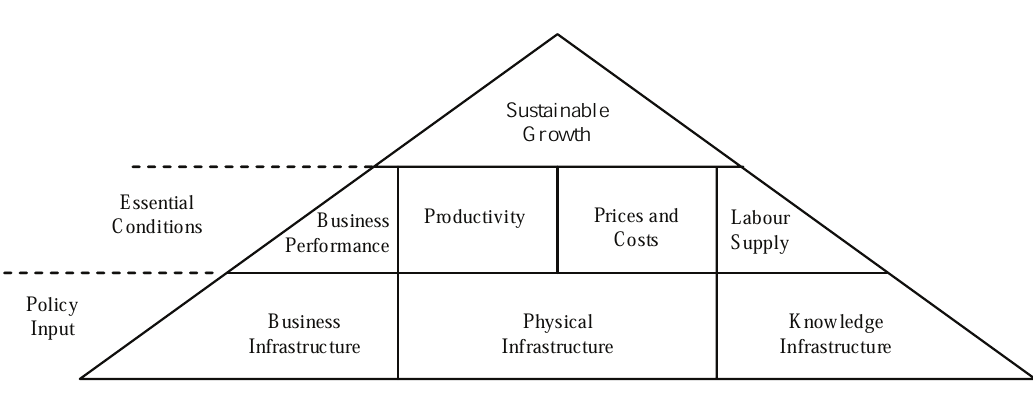
Fig. 4. The National Competitiveness Council (NCC) Competitiveness Pyramid. Source: Annual Competitiveness Report (2009: